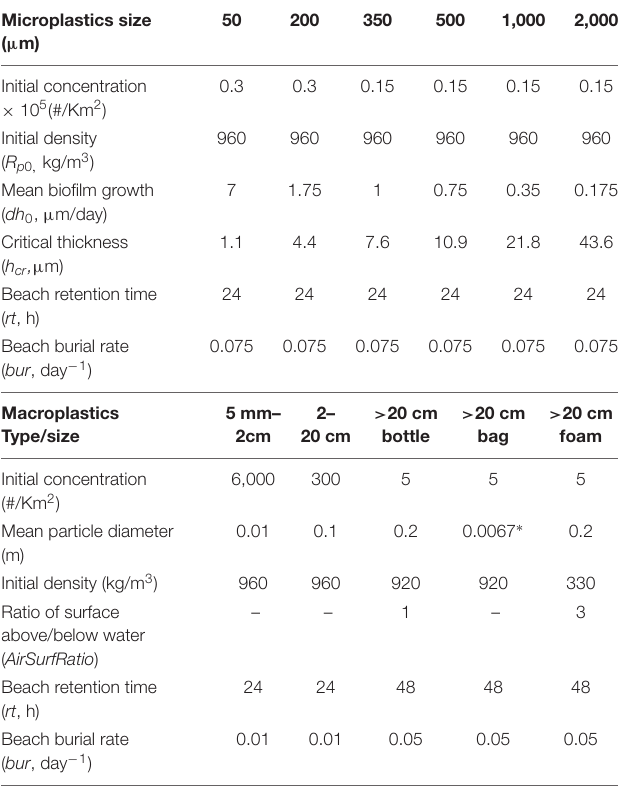
TABLE 1 | Model parameters and attributes for microplastics and macroplastics different